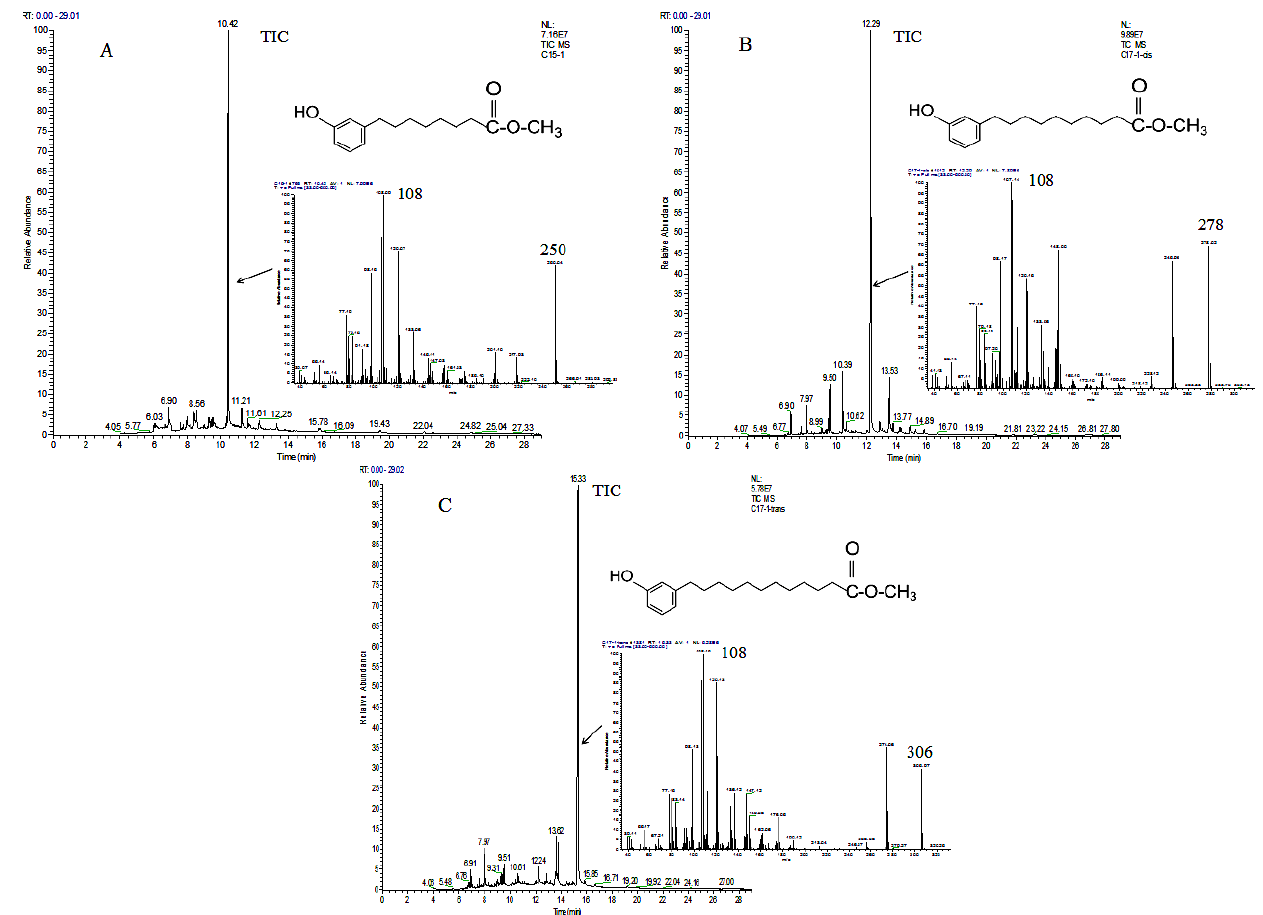
Figure 5. The GC-MS chromatogram and EI mass of the methyl esters of the compounds G-2 ( A ), G-5 ( B ), and G-6 ( C ).